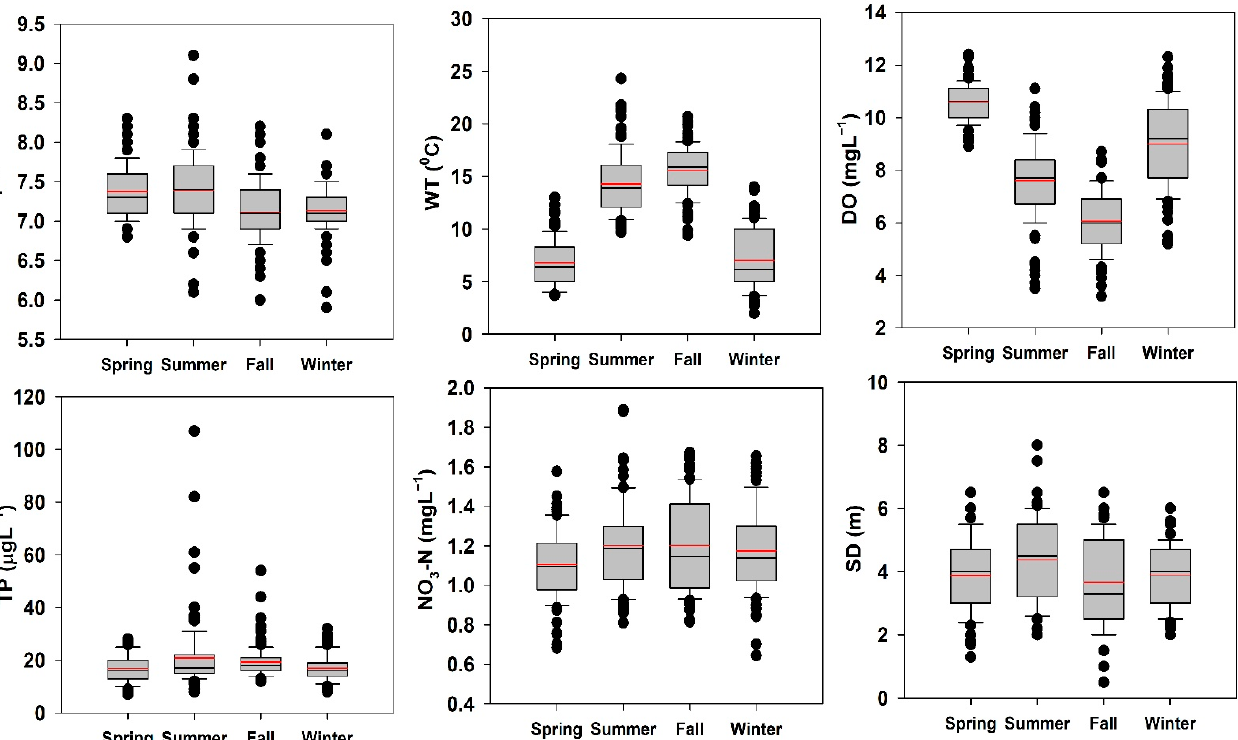
Figure 9. Seasonal variations of pH, WT, DO, TP, NO 3 -N, and SD in Andong Reservoir. (pH: hydrogen ion concentration; WT: water temperature; DO: dissolved oxygen; TP: total phosphorus; NO 3 -N: nitrate-nitrogen; SD: Secchi depth; spring: